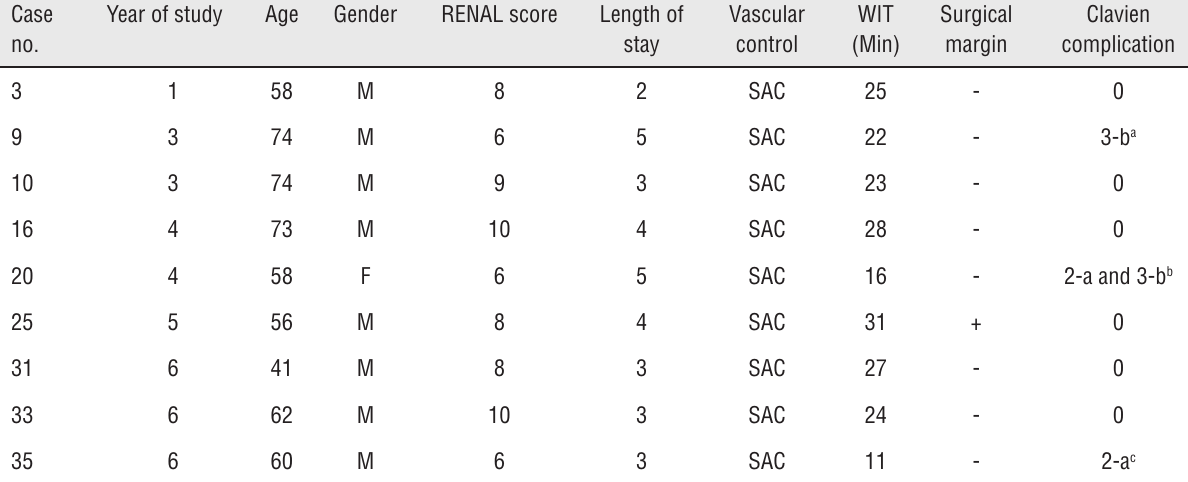
Table 2 - Trifecta failure